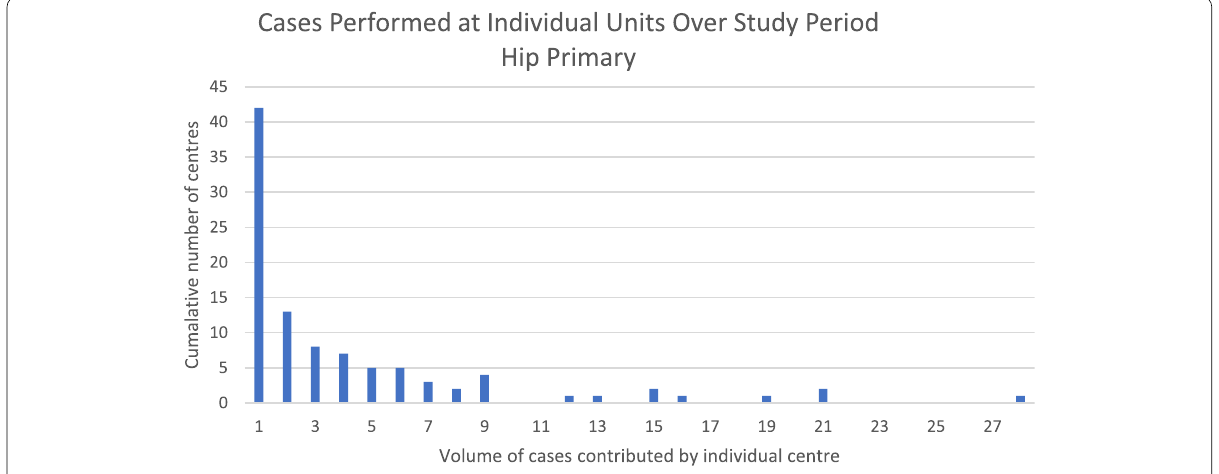
Fig. 9 Bar chart showing cumulative number of centers performing procedure volumes, hip primary surgery